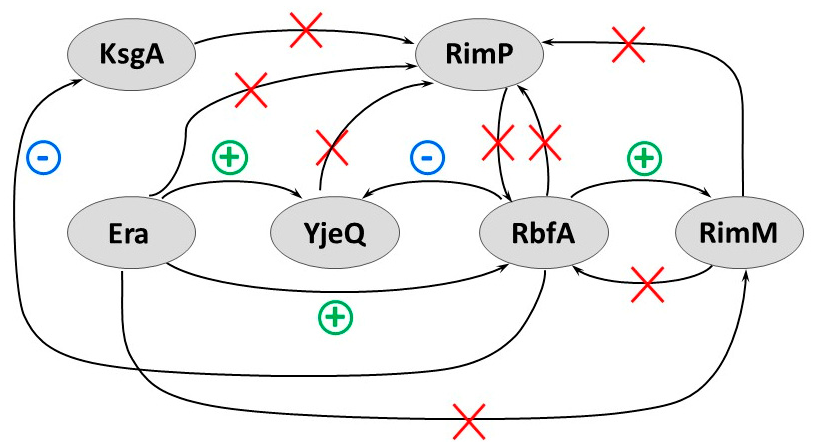
Figure 6. Network of functional interactions between the 30S assembly factors. Effects of the over ‐ production of one assembly factor on the defects caused by the lack of another one are shown by arrows. A plus sign indicates a positive effect, a minus sign indicates a negative effect, and a cross (×) signifies that no effects were observed. A positive effect implies the partial suppression of the defects of ribosome assembly. A negative effect implies the exacerbation of the defects of ribosome assembly. This network is described in the main text in more detail.